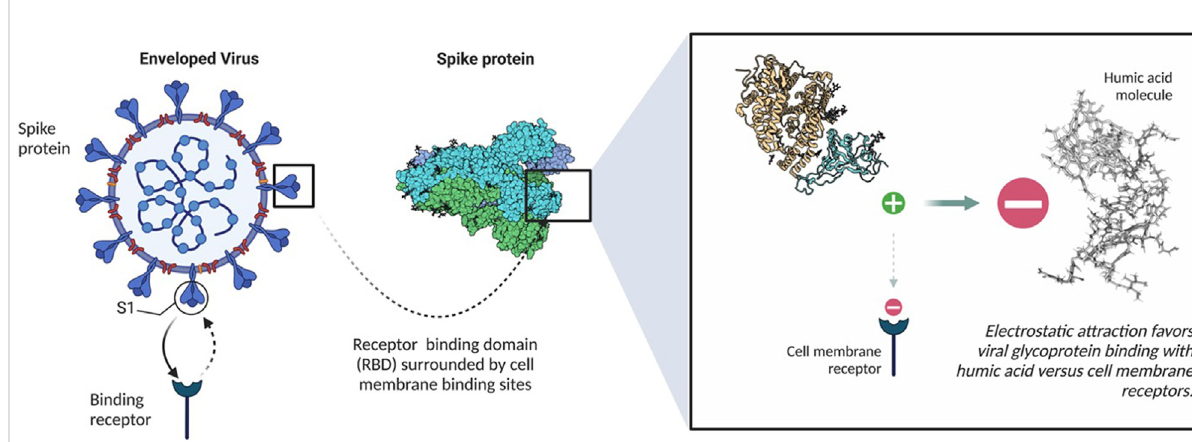
Binding mechanism of humic acid with spike proteins. Created with